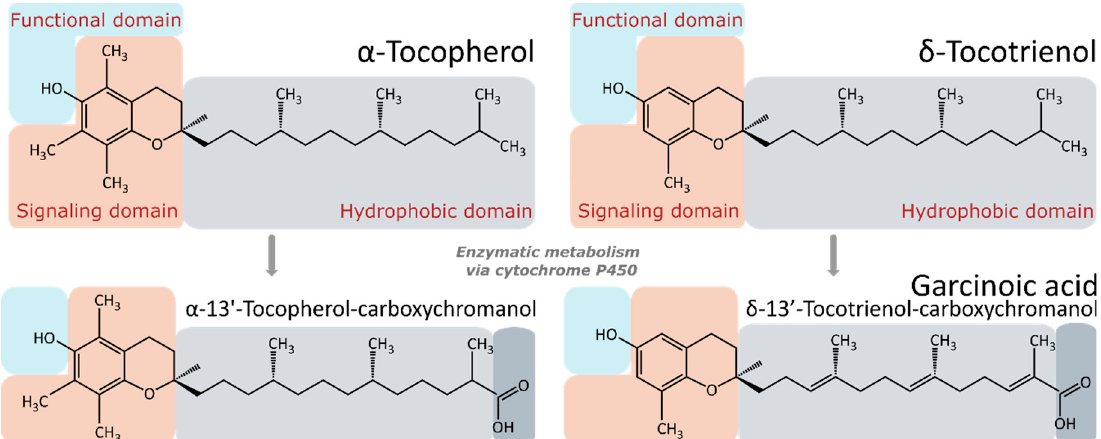
Figure 3. Structural similarity of α -tocopherol, δ -tocotrienol, α -13’-carboxychromanol and gar- cinoic acid. Three structural features can be postulated in the vitamin E analogues: the functional domain, the signaling domain and either the hydrophobic domain or the oxidized, i.e., activated side-chain.